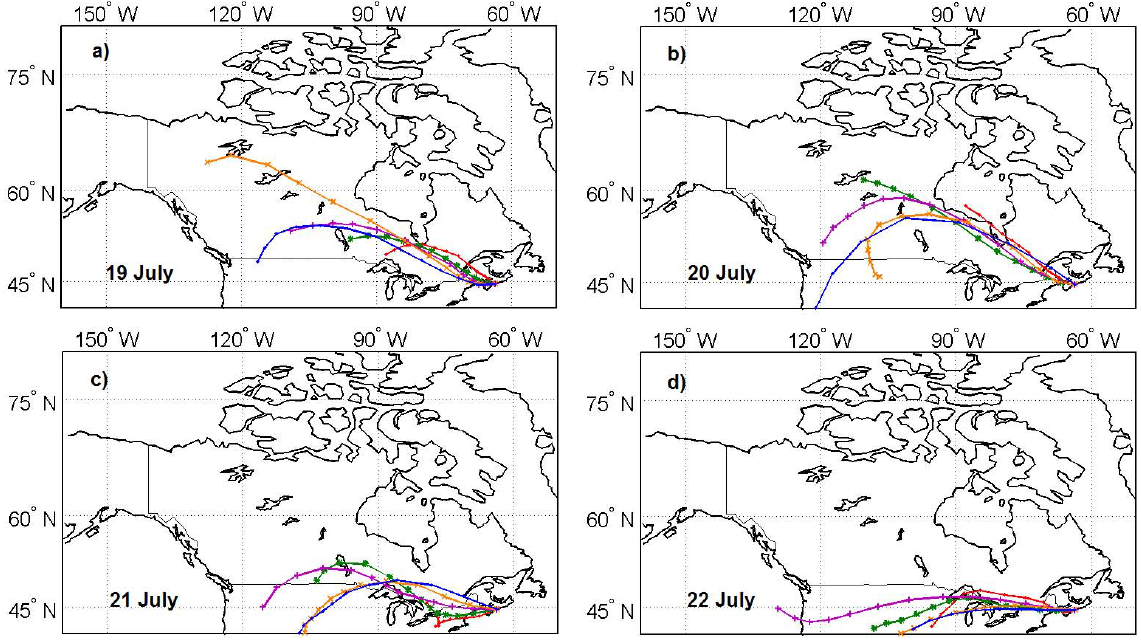
Fig. 5. Back trajectories from the CMC transport model. The back trajectories correspond to the origin of the air parcel overpassing Halifax at 18:00UTC on (a) 19 July, (b) 20 July, (c) 21 July and (d) 22 July 2011 at altitudes of 10km (orange crosses), 7km (blue dots), 5km (purple plus signs), 3km (green stars) and 1km (red dots). The markers indicate the location of the air parcel every 6h over a 72h